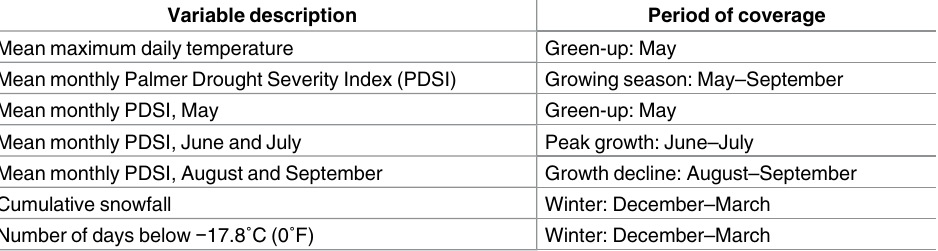
Table 2. Variables used to assessthe ability of weather to explain minor variations in the beaver den- sity index on non-managed streamsor function as drivers of trends on those streams. Each variable was computedfor the current year and the three preceding years. Variableswere standardized againsttheir long-termaverages (1983–2013). Variable description Period of coverage Mean maximum daily temperature Green-up: